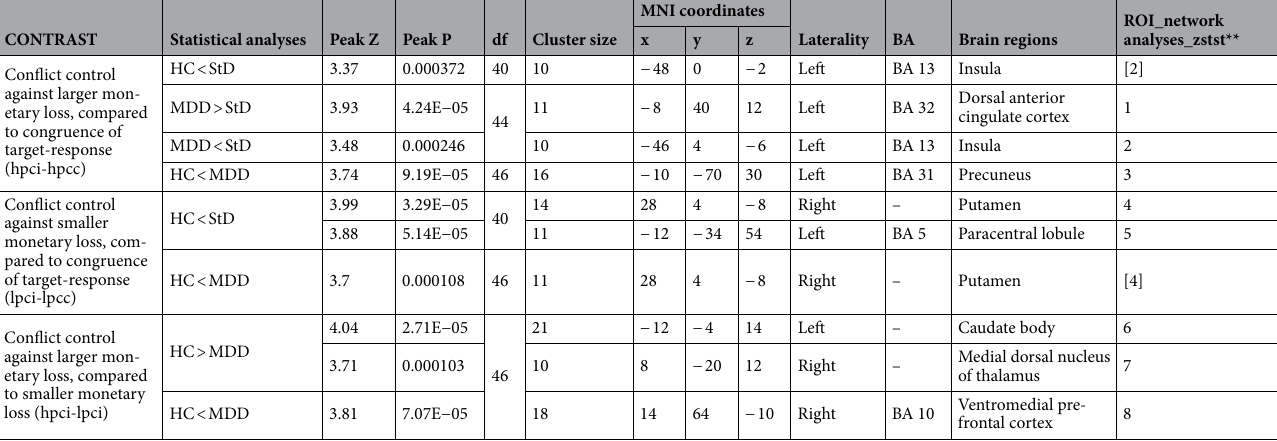
Table 2. Between-group comparisons for the task-related brain activation: control of color-location conflict in the middle of monetary punishment for error or delayed responses. Cluster-forming thresholds were p < 0.001 and k (voxel number) ≥ 10. BA Brodmann area, HC healthy controls, MDD major depressive disorder, StD subthreshold depression, hpci incongruent trial against larger monetary loss, hpcc Congruent trial